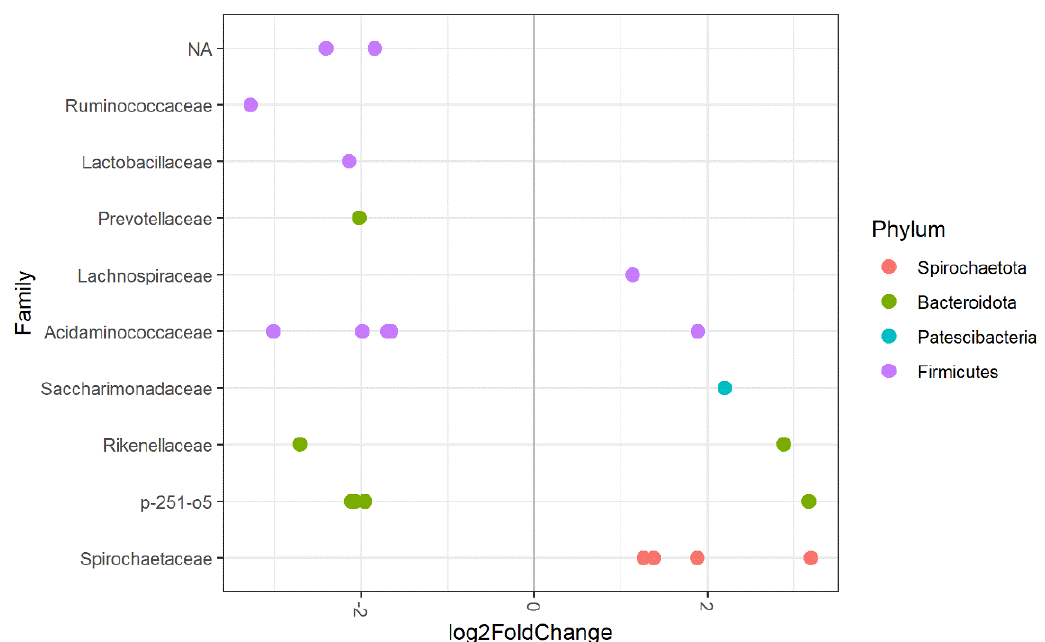
Figure 4. Differentially abundant ASVs grouped by family for horse type (ponies vs. horses) of the faecal microbiota in 61 horses and ponies. The log2 fold change in species abundance is shown on the x -axis. ASVs assigned to bacterial families on the left side of the plot are less abundant in ponies than horses, ASVs assigned to families depicted on the right side of the plot are more abundant in ponies than horses. NA = ASV belonging to an unknown family (colours indicate the phylum).